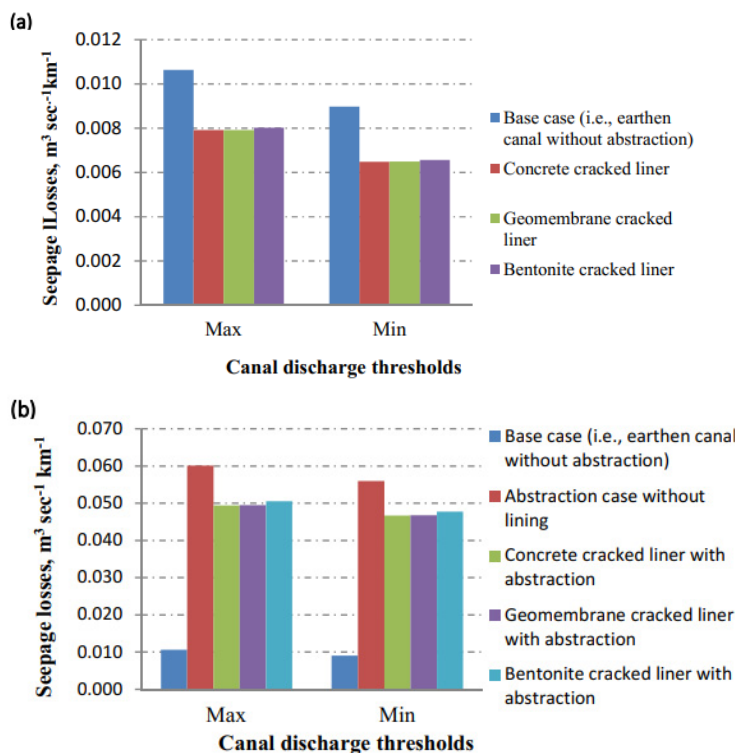
Figure 9. Canal seepage losses of different cracked liners, ( a ) without extraction and ( b ) with extraction.